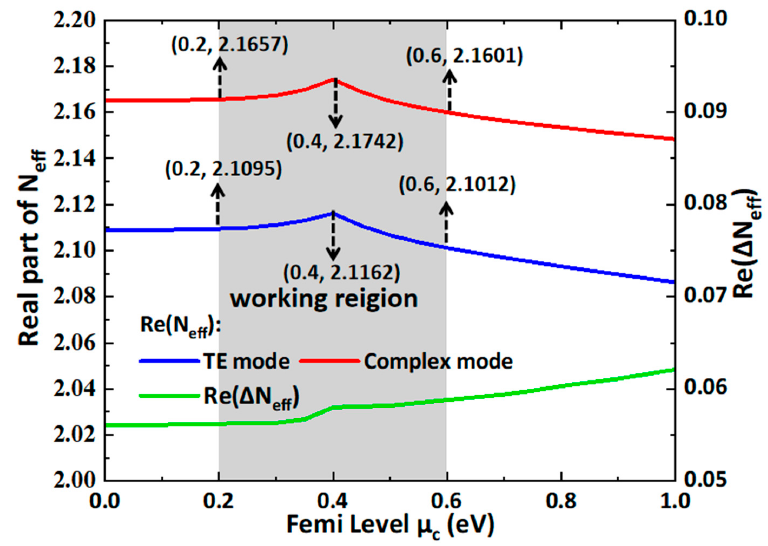
Figure 16. Re( N eff ) and Re( ∆ N eff ) of the TE mode and the complex mode versus Femi level, µ c . As shown in Figure 17, a sharp drop in PL can be observed with the µc increasing from 0.2 eV to 0.6 eV. Therefore, we define the “ON” state at µ c = 0.6 and the “OFF” state and 0.511 dB/µm, respectively. The difference between MD TE-mode and MD complex mode is only 0.007 dB/µm at λ = 1550 nm.